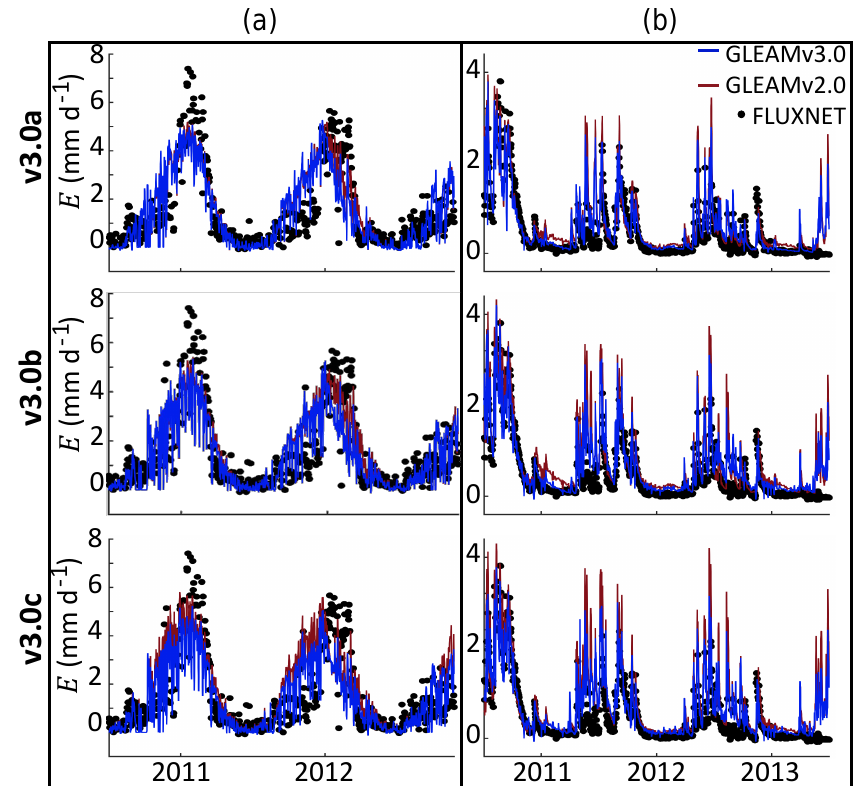
Figure 8. Time series of GLEAM and in situ measured evaporation for two in situ validation sites: US-Ne3 (left) and AU-ASM (right).